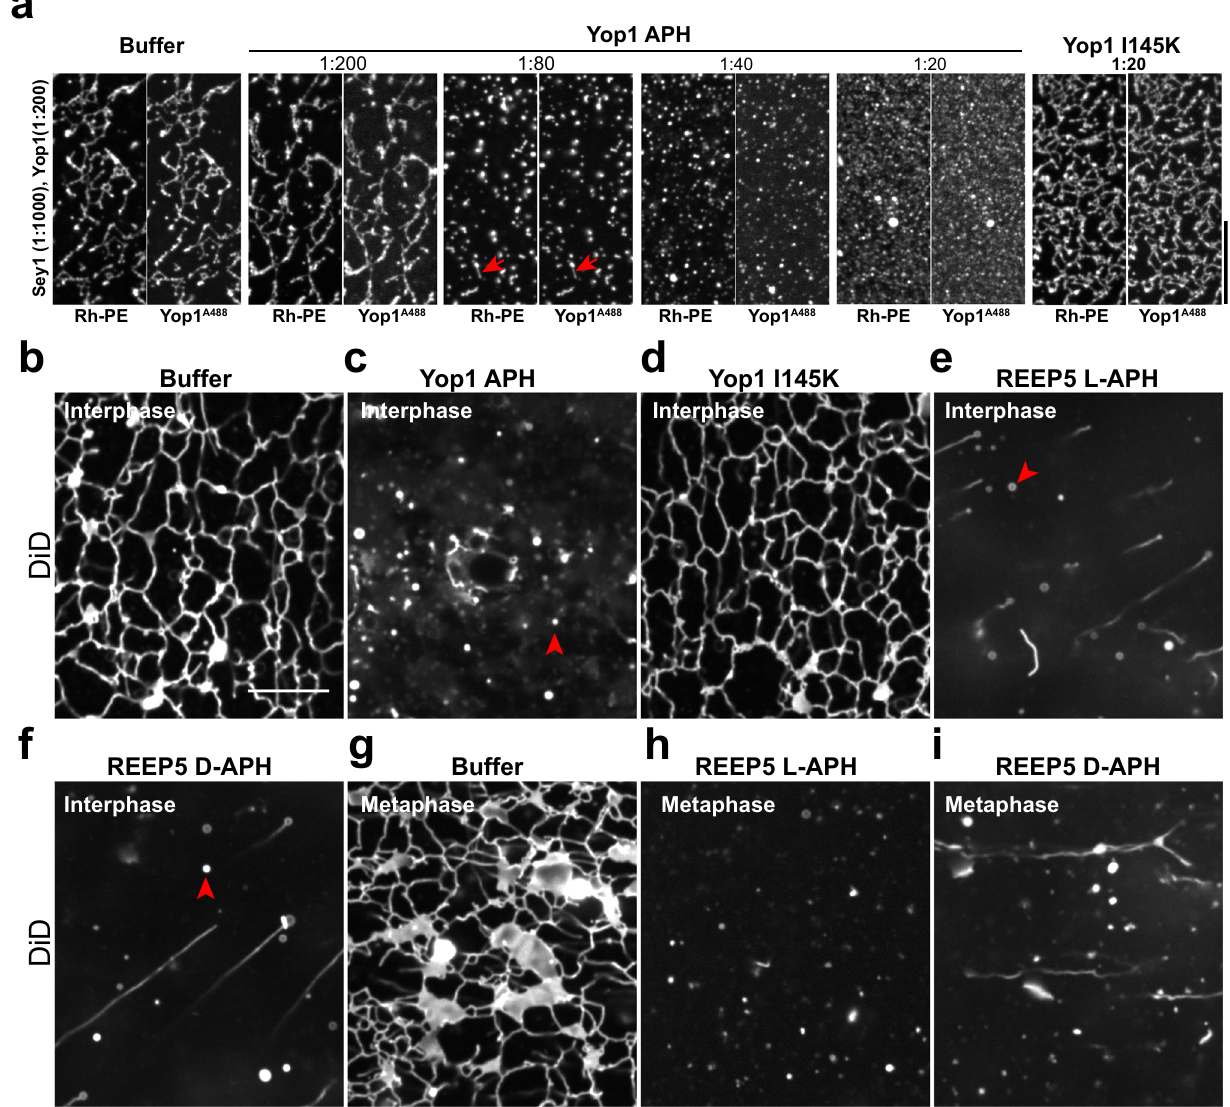
Fig. 7 APH peptides abolish membrane networks in a reconstituted system and Xenopus egg extracts. a Alexa 488-labeled Yop1 (Yop1 A488 ) was co- reconstituted with the GTPase Sey1 into liposomes containing S. cerevisiae lipids and fl uorescent Rh-PE at the protein to lipid ratios given on the left. Synthetic peptides corresponding to the APH of wild-type Yop1 or to a mutant in the APH (Yop1 I145K) were added at the molar ratios (peptide to lipid) given on the top. All samples were incubated with Mg 2 + and GTP, added 10 min before the peptides. The samples were analyzed for fl uorescence of lipid and protein. Arrows point to residual short tubules. The experiment was performed two times. b An interphase tubular network was generated with Xenopus egg extract and stained with the fl uorescent dye DiD. The network was visualized with a fl uorescence microscope with excitation at 642 nm. Bar, 10 µ m. c As in b , but in the presence of 100 µ M of a synthetic peptide corresponding to wild-type Yop1 (Yop1 APH). d As in b , but with a peptide carrying a point mutation in the APH (Yop1 I145K). e As in b , but with a peptide corresponding to the APH of wild-type Xenopus REEP5 (REEP5 L-APH). f As in e , but with a peptide containing D-amino acids (REEP5 D-APH). These experiments were performed four times. g Network generated with Xenopus egg extract in metaphase. h As in g , but in the presence of REEP5 L-APH. i As in g , but in the presence of REEP5 D-APH. These experiments were performed three